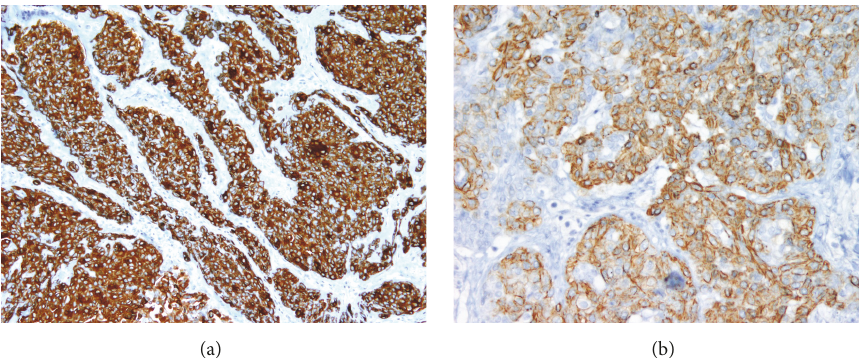
Figure 3: (a) Immunohistochemistry of the tumors cells shows strong and diffuse positivity for alpha smooth muscle actin ( 𝛼 -SMA) (H&E; × 200). (b) Nicely uniform pericellular positivity for type IV collagen (H&E; ×